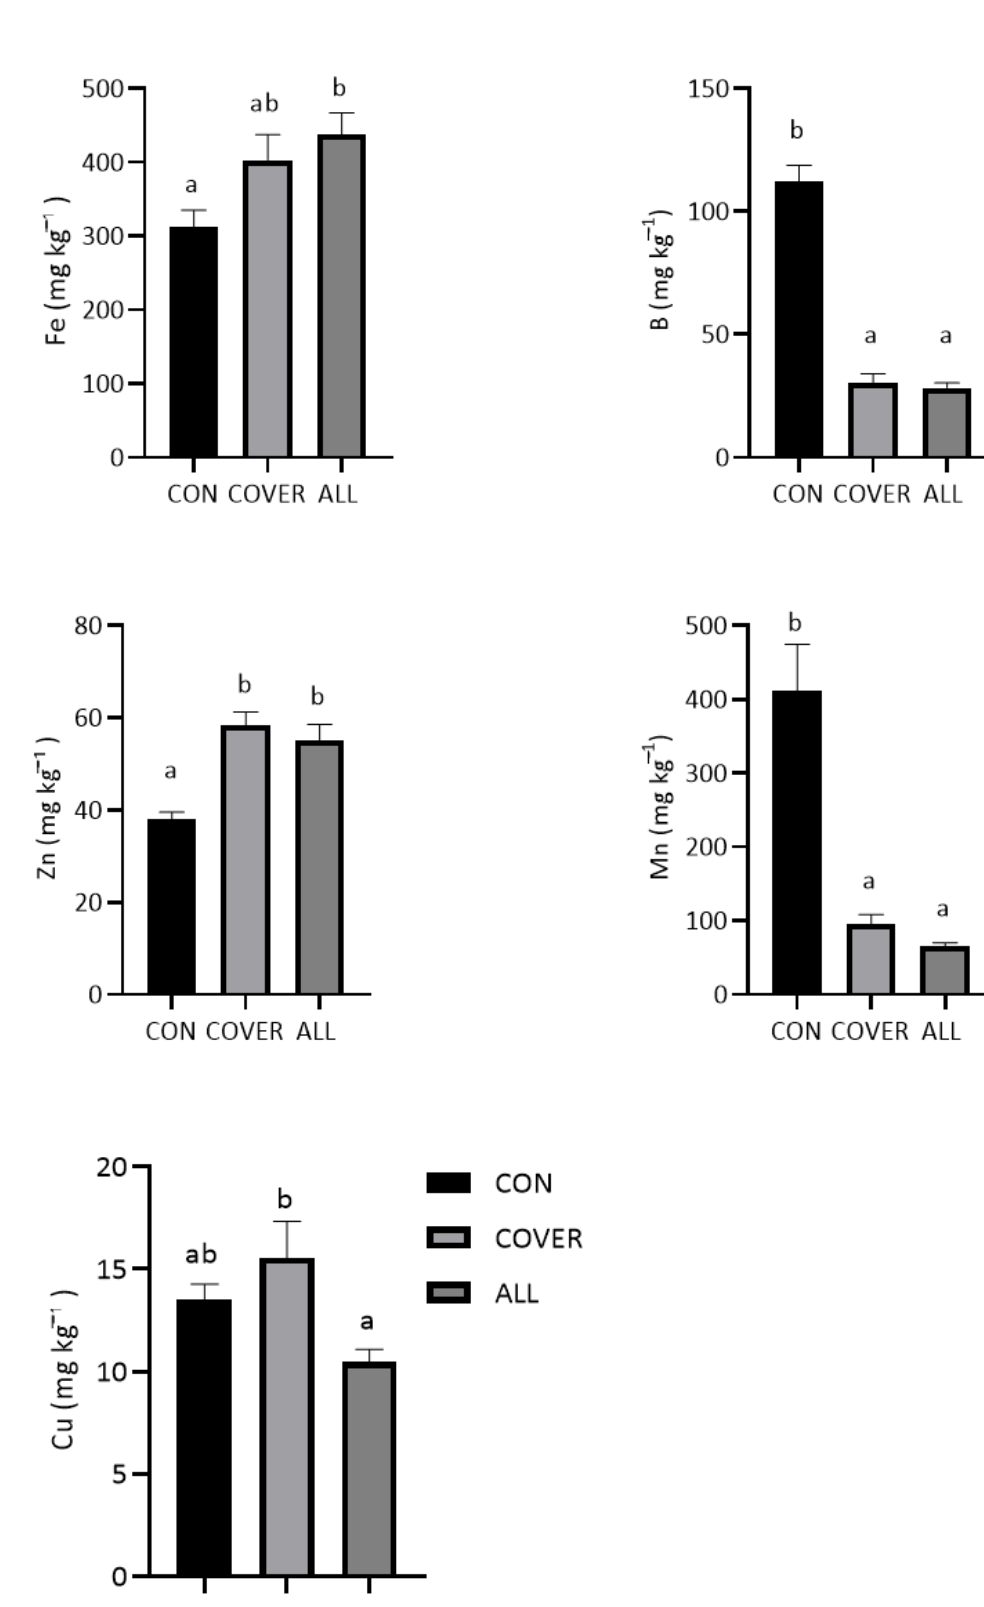
Figure 5. Nutrient concentrations (mg kg − 1 dry weight) of seeded cover crops in the COVER and ALL treatments and spontaneous plants in the CON treatment. Mean values ± SE per each treatment is presented. Different letters indicate significance at p < 0.05 (LSD test).